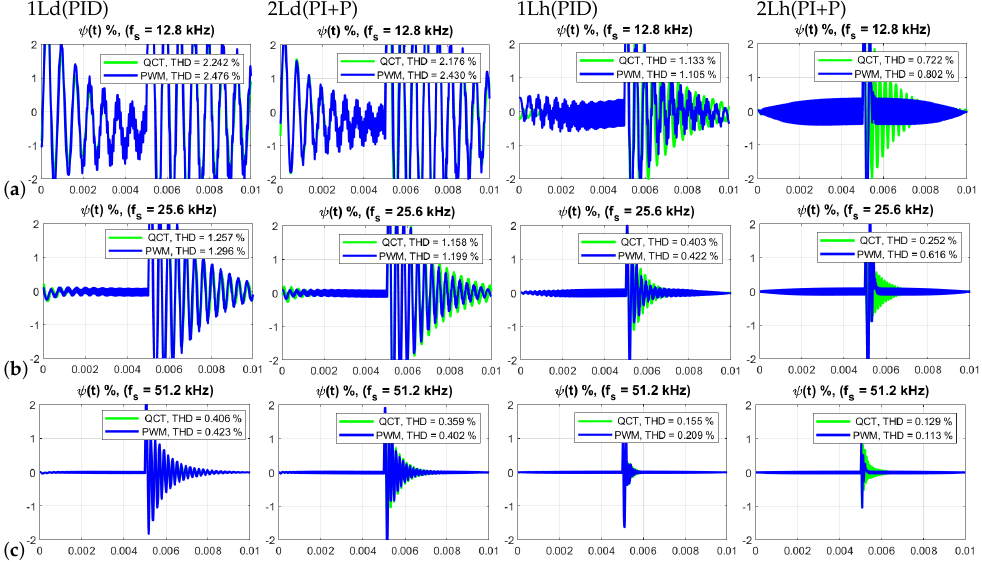
Figure 21. Distortion function ψ ( t ) and THD values of v out ( t ) in 1L (PID) and 2L (PI+P) control sys- tems optimized for the rectifier resistive load operating at different carrier frequencies f s : ( a ) 12.8 kHz, ( b ) 25.6 kHz, and ( c ) 51.2 kHz. Plots in ( a ) extending beyond the display window are displayed in the appropriate scale in Figure